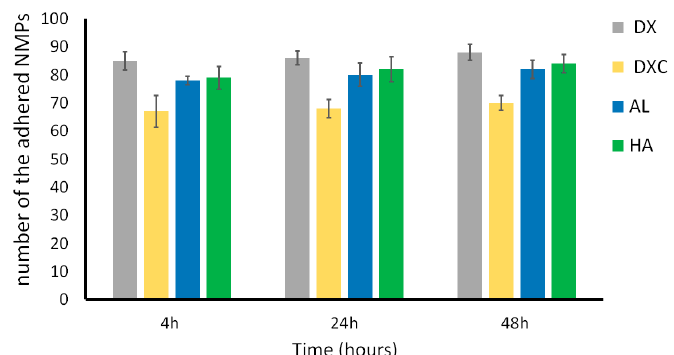
Figure 8. NMP cellular uptake by cells cultured with FITC-labeled NMPs in mw24 plates for 4 h, 24 h, or 48 h. Free NMPs counted via Bürker–Türk counting chamber. Results are presented as number of adhered NMPs over the NMP number added to the medium at time 0.